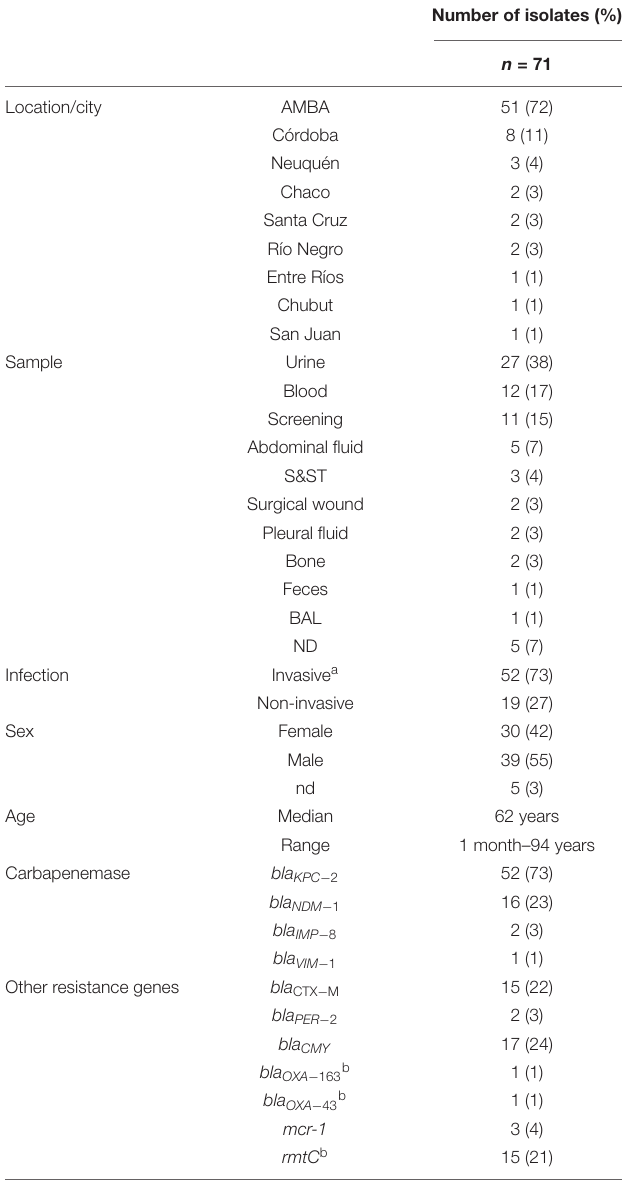
TABLE 1 | Epidemiological data of the